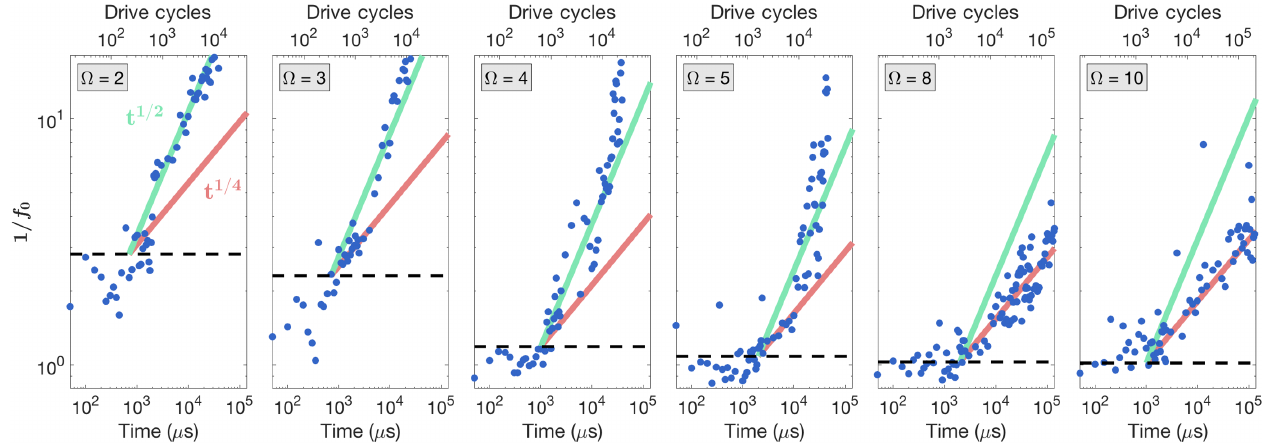
FIG. 5. Effect of drive frequency on the long-time evolution of Floquet matter. Panels show evolution of the participation ratio 1 =f 0 for a ¼ 30 nm, α ¼ 3 , and varying drive frequency Ω as indicated in the inset. Dashed line indicates the PGE prediction for the constant- f plateau which extends as the frequency increases. The time dependence of heating away from the prethermal plateau is observed to be strongly Ω dependent: At low frequency, the participation ratio grows approximately as the square root of time (green solid line), while at the highest frequency, the heating is consistent with a t 1 = 4 dependence (red solid